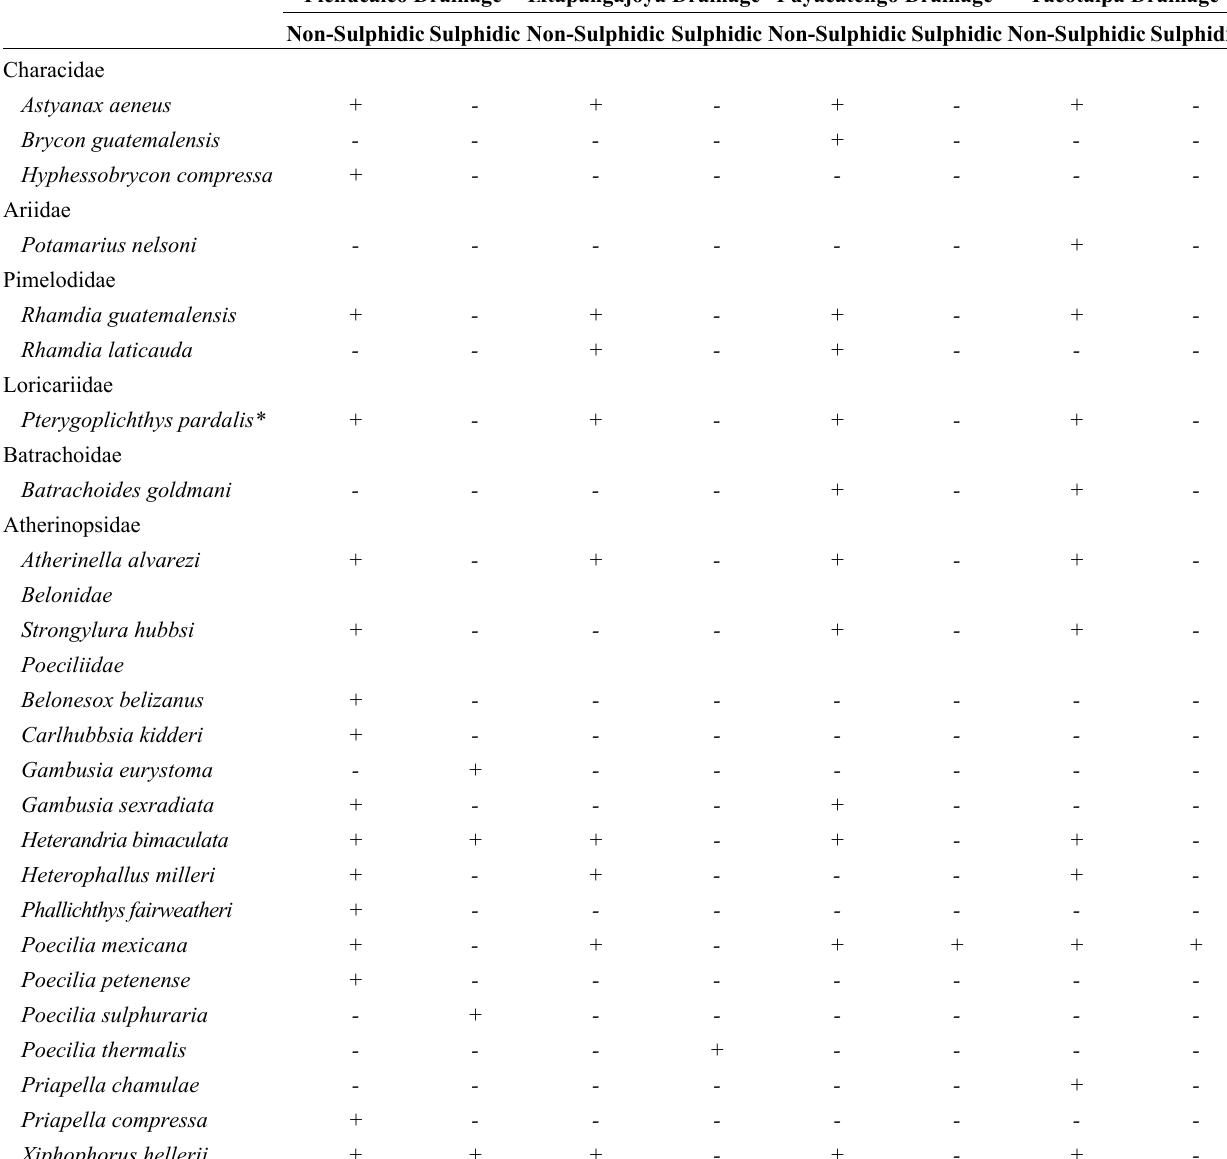
Table 4. Summary of fish species identified in qualitative samples from sulphidic and non-sulphidic habitats of four river drainages between 2004 and 2013. Differences in species composition among drainages primarily reflect patterns of endemism (e.g., different Priapella species with allopatric distributions occur in the Tacotalpa and the Pichucalco drainages) and differences in habitat characteristics. For example, non-sulphidic habitats in the Tacotalpa and Puyacatengo drainages primarily included small streams and swiftly flowing piedmont rivers that are characterised by species like Heterophallus milleri , Priapella chamulae , Paraneetroplus gibbiceps , and Theraps lentiginosus . In contrast, habitats in the Pichucalco drainage also included sluggish lowland rivers, where species like Hyphessobrycon compressa , Belonesox belizanus , Phallichthys fairweatheri , Astatheros robertsoni , and Petenia splendida